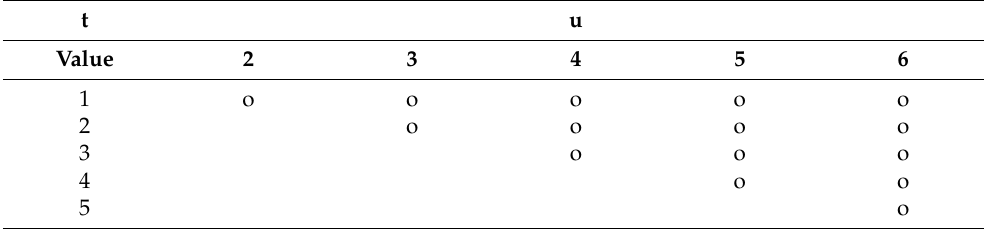
Table 5. Estimation problems ( t , u ) in Moradian